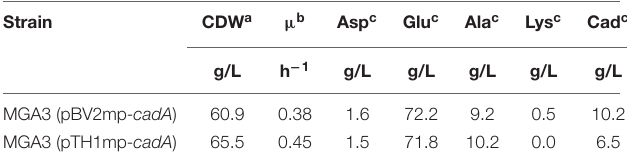
TABLE 2 | Fed-batch methanol fermentation production data of strains MGA3 (pBV2mp- cadA ) and MGA3 (pTH1mp- cadA ). Strain CDW a µ b